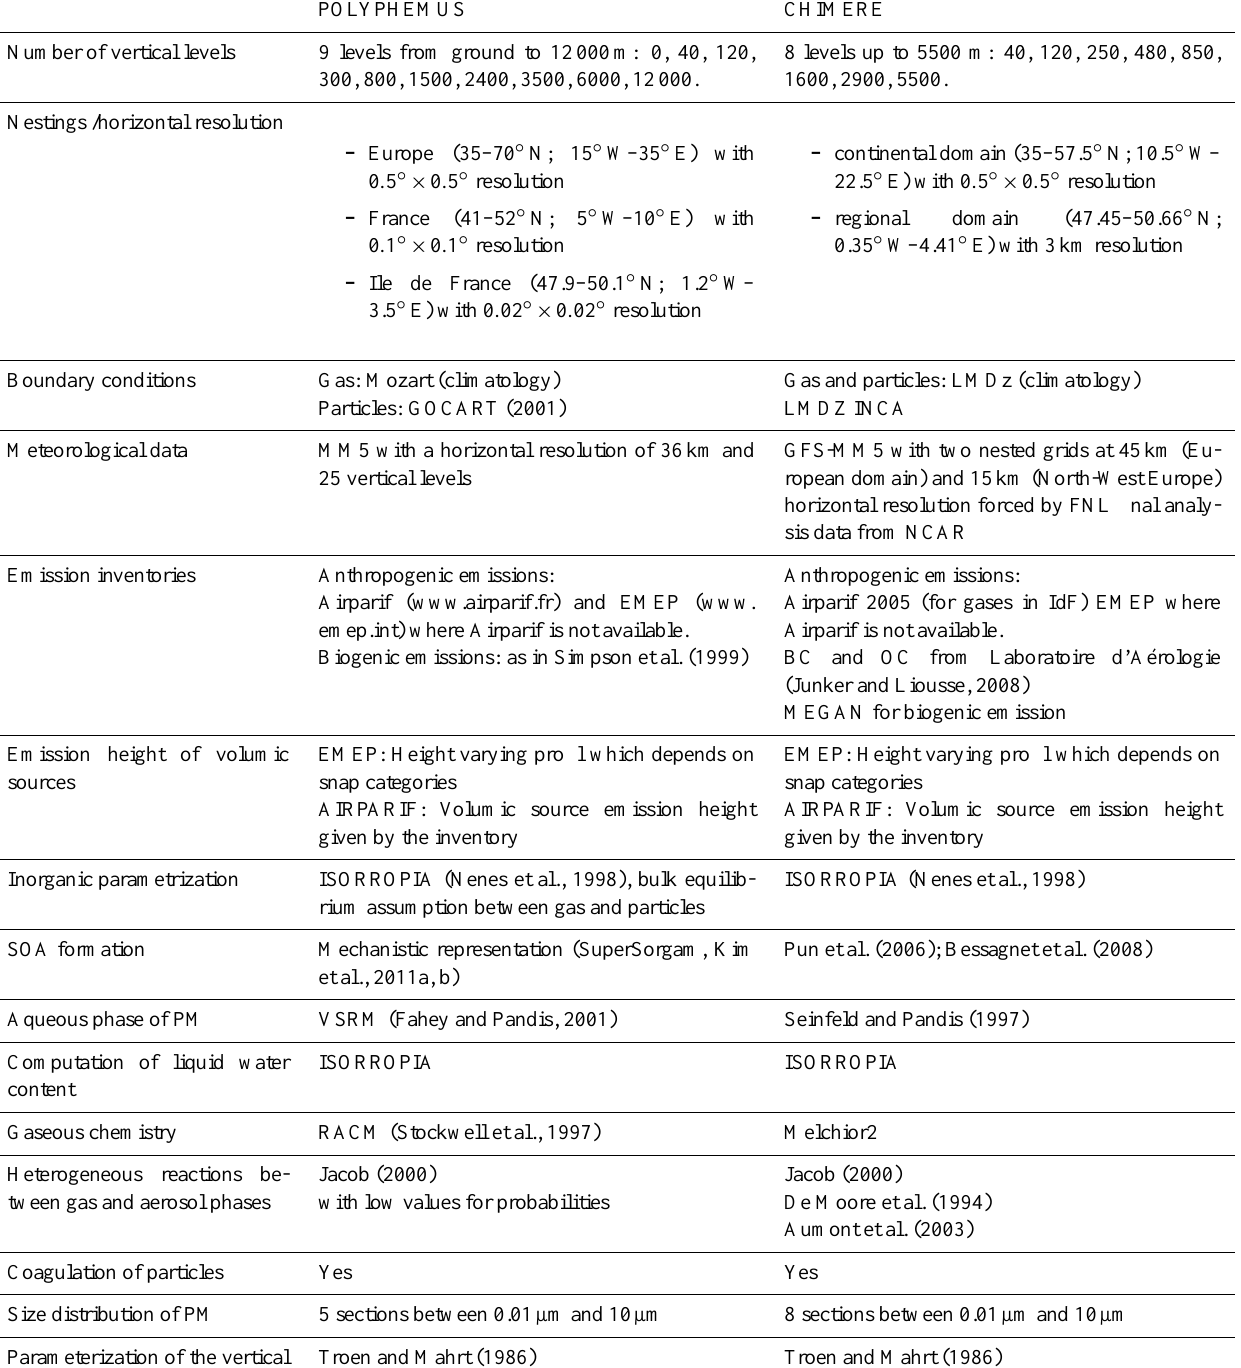
Table 4. Main characteristics of POLYPHEMUS platform and CHIMERE model.